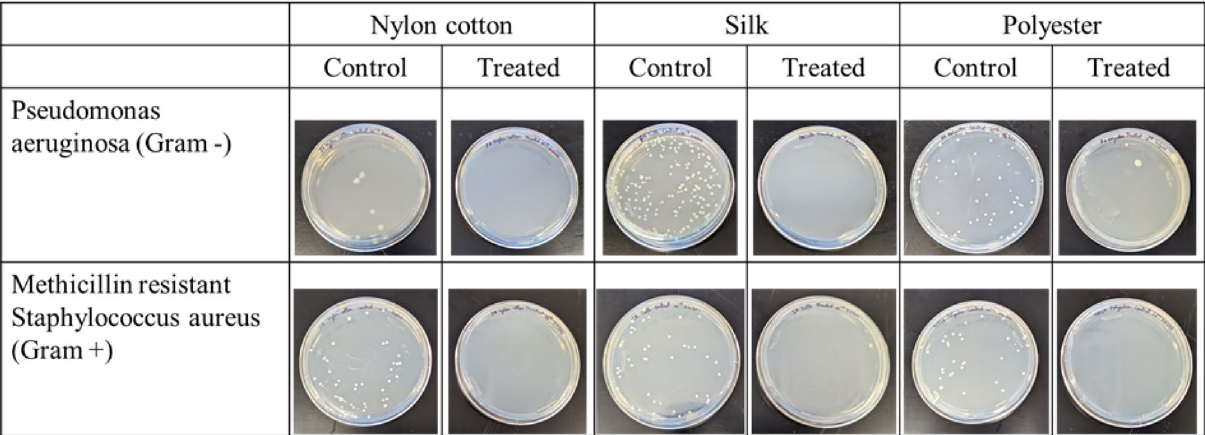
Figure 5. Selected photos of cell culture plates used in antimicrobial testing via cell counting for samples eluted after 24 h with 10 5 X